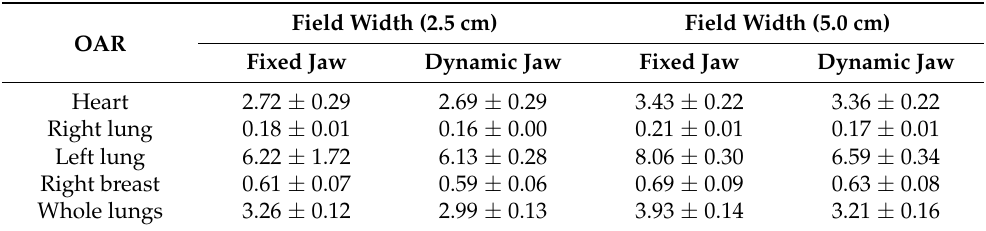
Figure 6. CT images (upper and middle rows) and 3D dose distribution (lower row) between jaw mode at ( a ) fixed and ( b ) dynamic jaw modes at the 5.0 cm field width. Red and blue colors indicate target coverage of more than 95% and 30%, respectively, of the prescription dose. Table 2. Mean absorbed dose (Gy) of the organ at risks (OARs) for two jaw modes (fixed versus dynamic) at a field width of 2.5 cm and 5.0